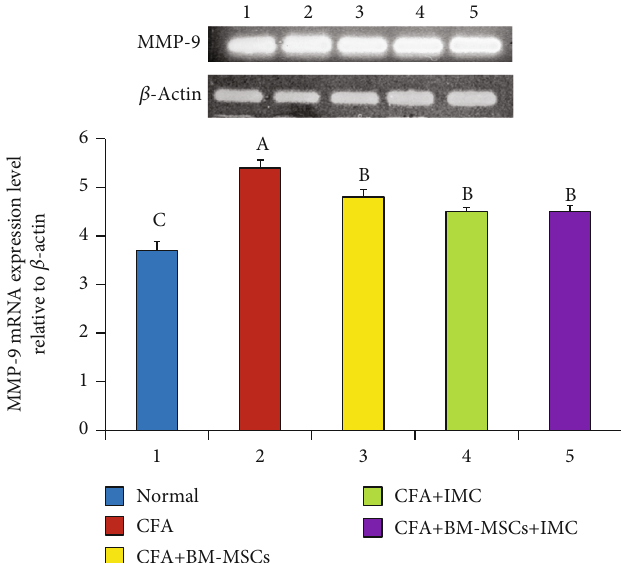
Figure 6: E ff ect of BM-MSCs and/or IMC on the MMP-9 expression level relative to β -actin in CFA-induced rats. Means, which have di ff erent symbols, A, B, and C, are signi fi cantly di ff erent at p < 0 : 05 .